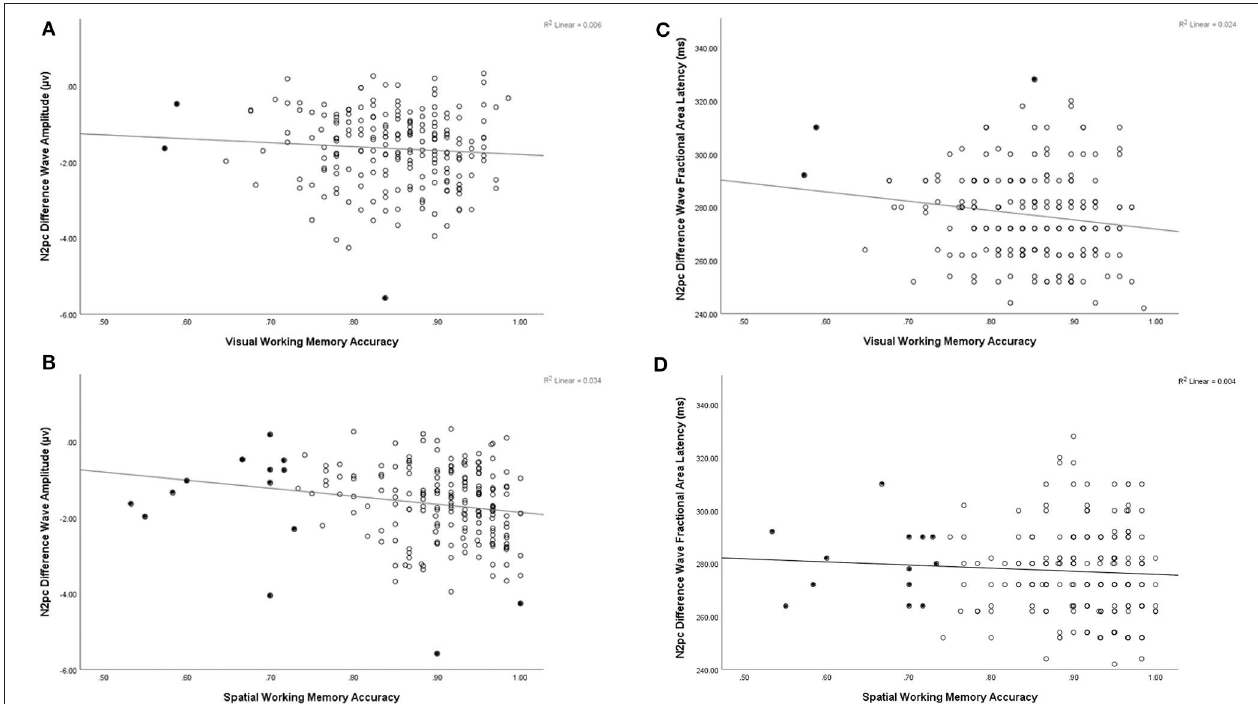
FIGURE 4 | Illustrative scatter plots to show relation between N2pc and working memory tasks (A) N2pc amplitude plotted by accuracy on visual working memory task, (B) N2pc amplitude plotted by accuracy on spatial working memory task, (C) N2pc fractional area latency plotted by accuracy on visual working memory task, (D) N2pc fractional area latency plotted by accuracy on spatial working memory task. Filled in points represent data points excluded in correlations presented with bivariate and univariate outliers removed in Table 1 .